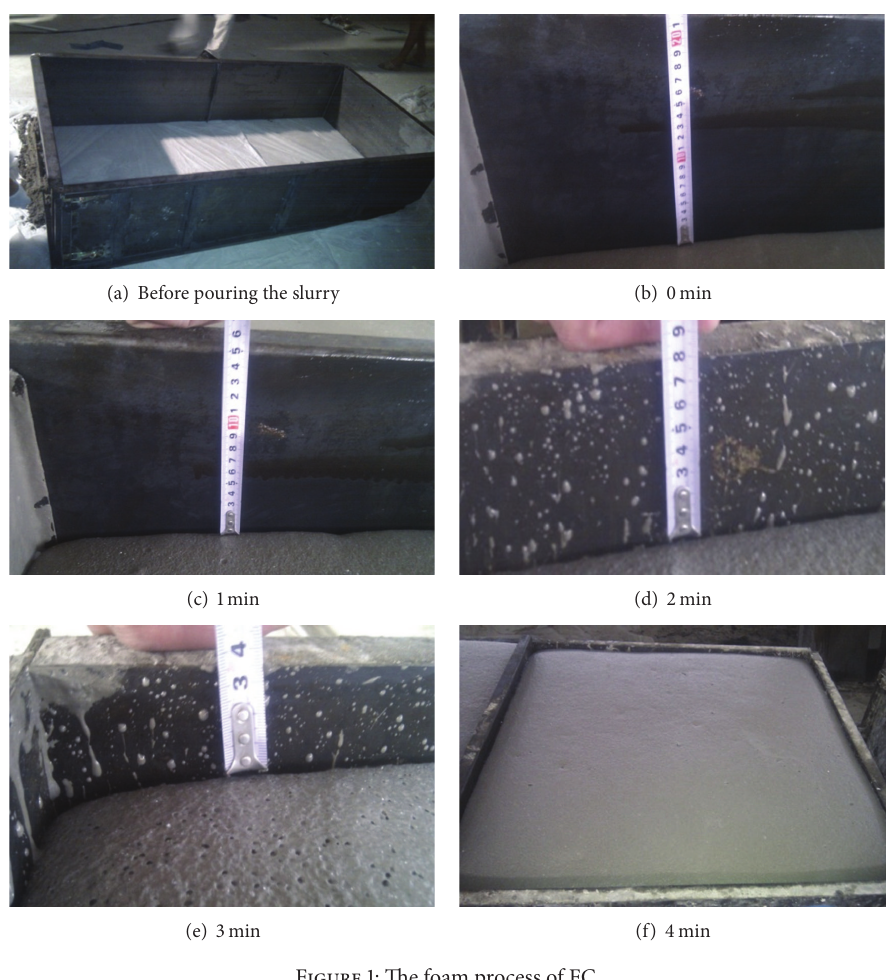
Figure 1: The foam process of FC.